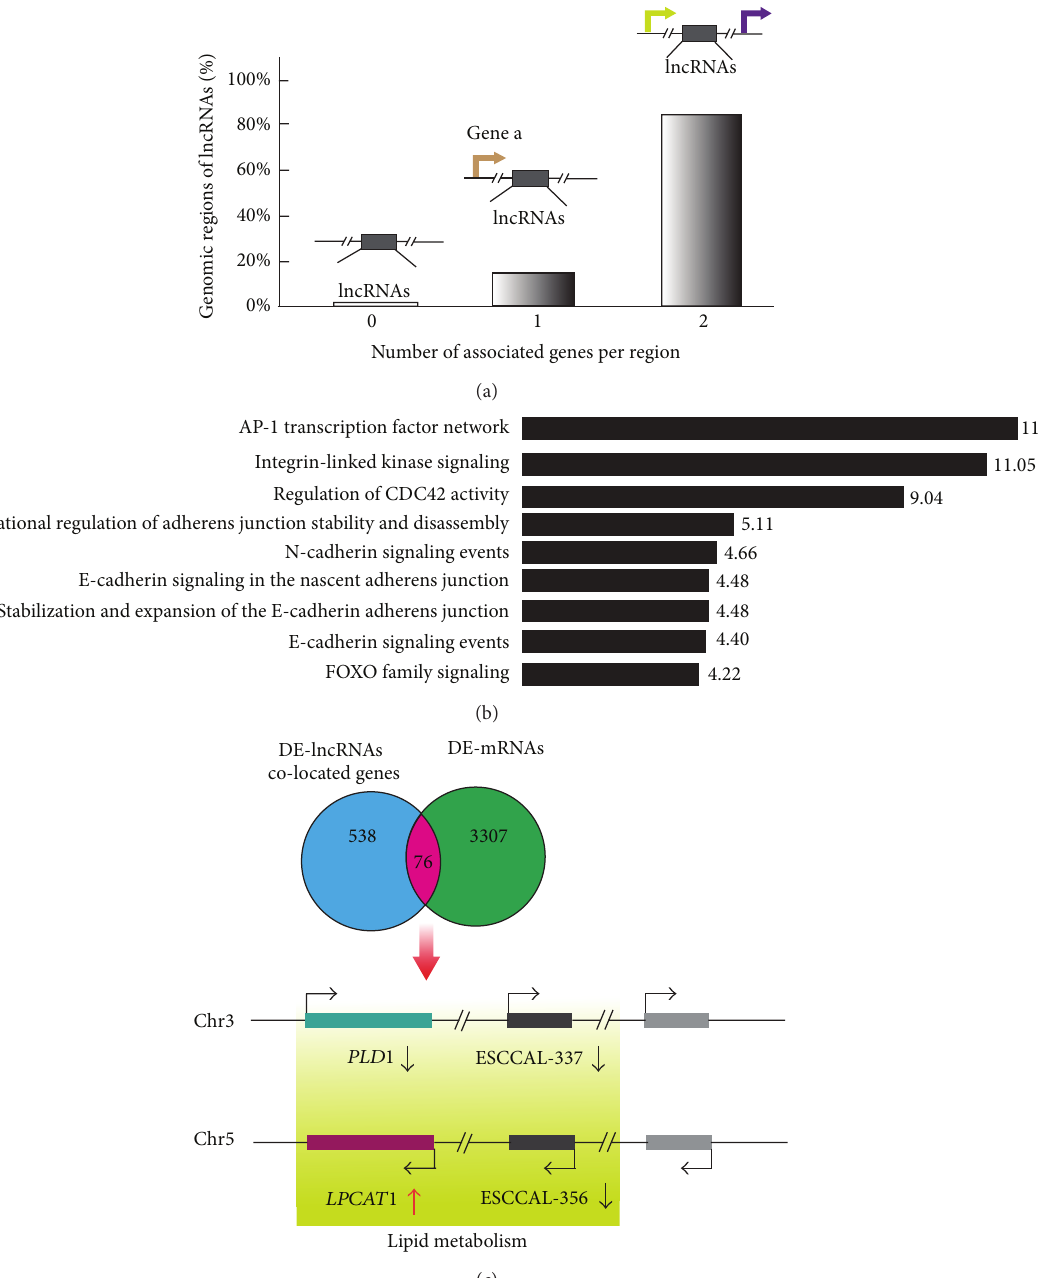
Figure 3: Identification of lncRNAs co-located and co-expressed neighboring genes in esophageal squamous cell carcinoma (ESCC). (a) Identification of neighboring genes of the DE-lncRNAs. The genomic coordinate information of 410 DE-lncRNAs was used to search neighboring genes whose genomic locations are within ∼ 5 kb upstream and ∼ 1kb downstream of the lncRNA and may extend to 1000kb in both directions using GREAT software (http://bejerano.stanford.edu/great/public/html/index.php). The percentage of DE-lncRNAs harboring zero, one, or two neighboring genes is presented. (b) Gene Ontology (GO) enrichment analysis of lncRNAs co-located genes. Identified gene enriched pathways/terms are listed on the left; the length of horizontal bars and the numbers on the right indicate the percentage of genes involved in each pathway/term. (c) LncRNAs co-located and co-expressed coding mRNAs. Overlap of 538 DE-lncRNA co-located genes with 3307 DE-mRNAs in microarrays identified 76 lncRNAs co-located and co-expressed coding mRNAs (list in Table 2). GO enrichment analysis suggests phospholipase D1 ( PLD1 ) and lysophosphatidylcholine acyltransferase1 ( LPCAT1 ) are involved in ether lipid metabolism pathway. Genomic location shows that PLD1 is located at − 22,068 bp upstream of ESCCAL-337 lncRNA on Chr 3 and LPCAT1 is at − 21,250 bp upstream of ESCCAL-356 lncRNA on Chr